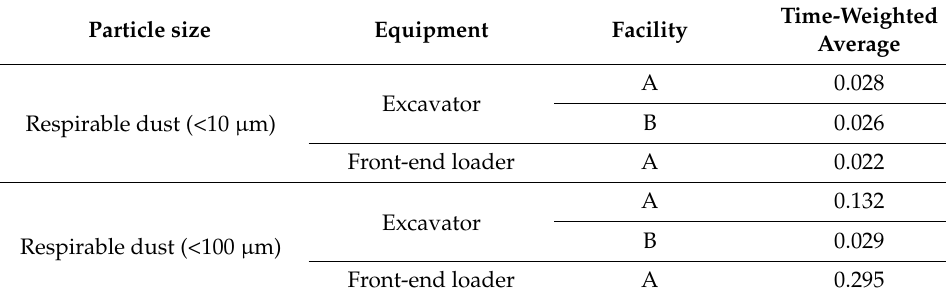
Table 4. Main results of Sepadi et al. [54] concerning equipment.